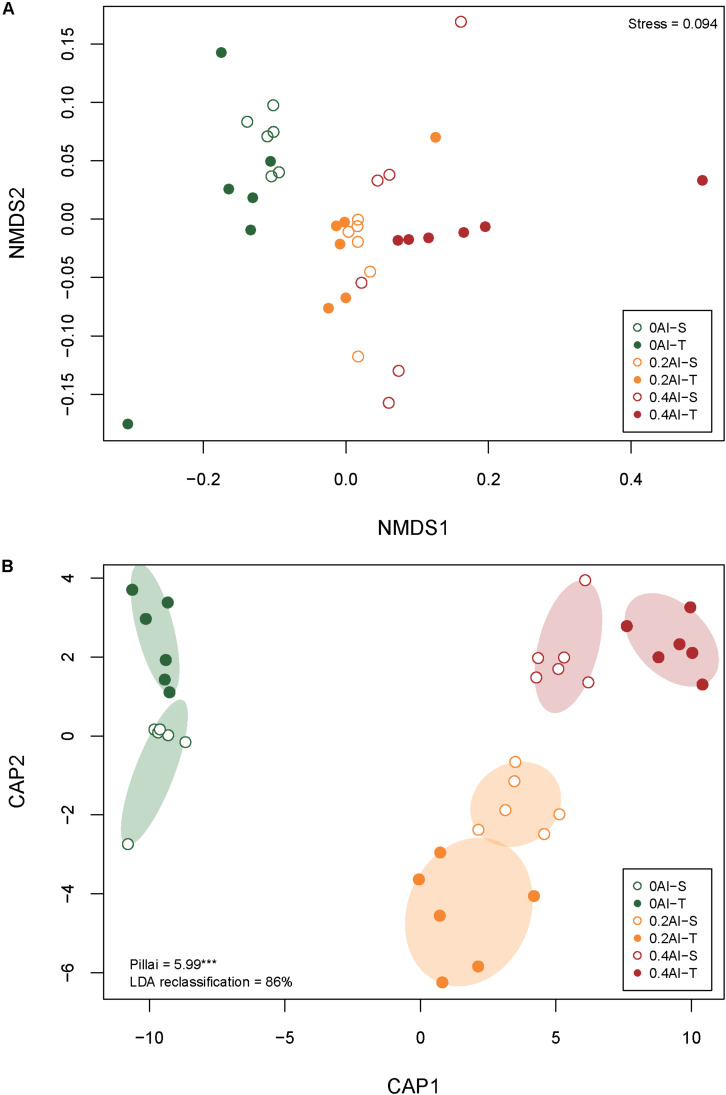
Non-metric multidimensional scale (NMDS) (A) and canonical analysis of principal coordinates (CAP) (B) based on Bray-Curtis dissimilarities showing differences in rhizosphere fungal community structures at 0 g kg–1 0.2 g kg–1, and 0.4 g kg–1 Al concentrations The stress value for the NMDS as well as Pillai’s trace and the leave-one-out re-allocation success rate of the linear discriminant analysis for the CAP are provided in the plot corners. Al-T: Al-tolerant soybean genotypes; Al-S: Al-sensitive soybean genotypes.